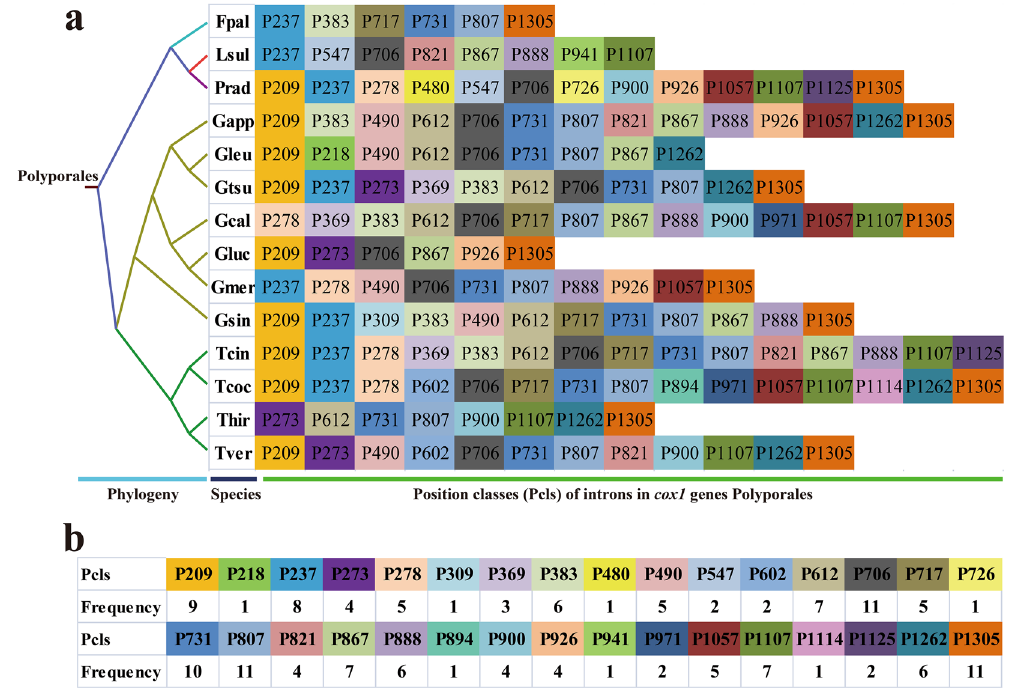
Figure 7. Position class (Pcl) information of cox1 gene of the 14 Polyporales species. a, Pcls (orthologous introns) were named according to the insert sites (nt) in aligned reference cox1 gene (MH252535). The phylogenetic positions of the 14 Polyporales species were established using the Bayesian inference (BI) method and Maximum Likelihood (ML) method based on combined mitochondrial gene set. b, the frequency of each Pcl in the 14 Polyporales